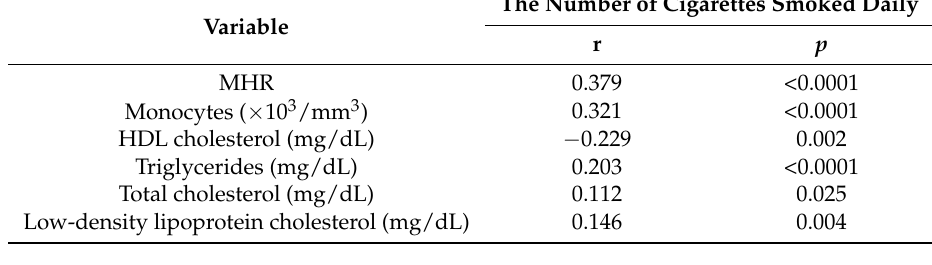
Table 4. Pearson’s correlation analysis between the number of cigarettes smoked daily, MHR and blood lipid levels.